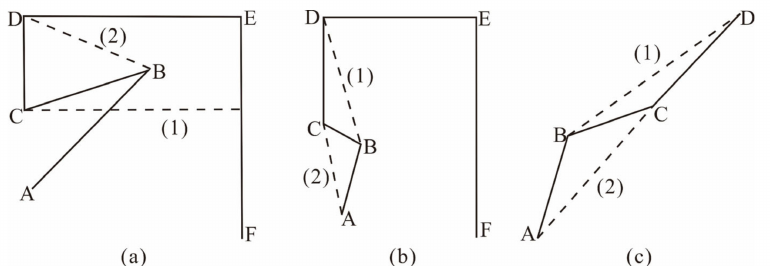
Figure 5. Changes in building characteristics after applying local-structure-based operation: ( a ) gen- erate self-intersection; ( b ) damage orthogonal features. ( a – c ) Operations may lead to changes in area, main orientation, and position of a